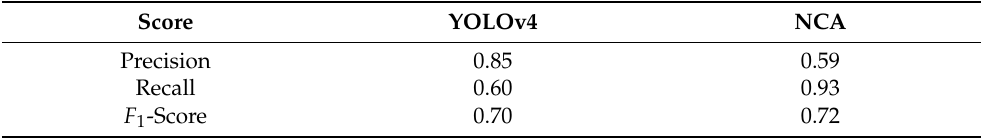
Figure 10. Confusion matrixes for ( A ): YOLOv4 ‐ based method and ( B ): NCA ‐ based method. TP—the model detected a lesion where it actually exists; FP—the model detected a lesion where it actually does not exist; FN—the model did not detect the lesion, where it actually exists. Table 4 shows the values of Precision, Recall, F 1 ‐ score for test set.